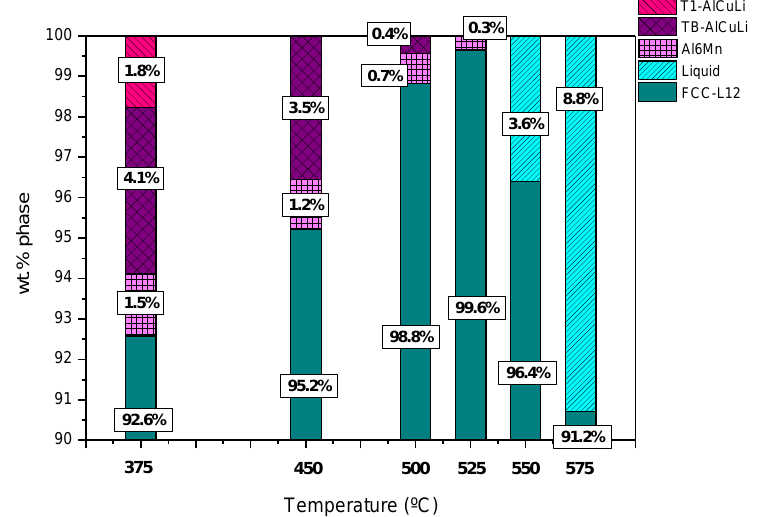
Figure 8. Weight percent of the phases at different temperatures for the Al – Cu – Li alloy.